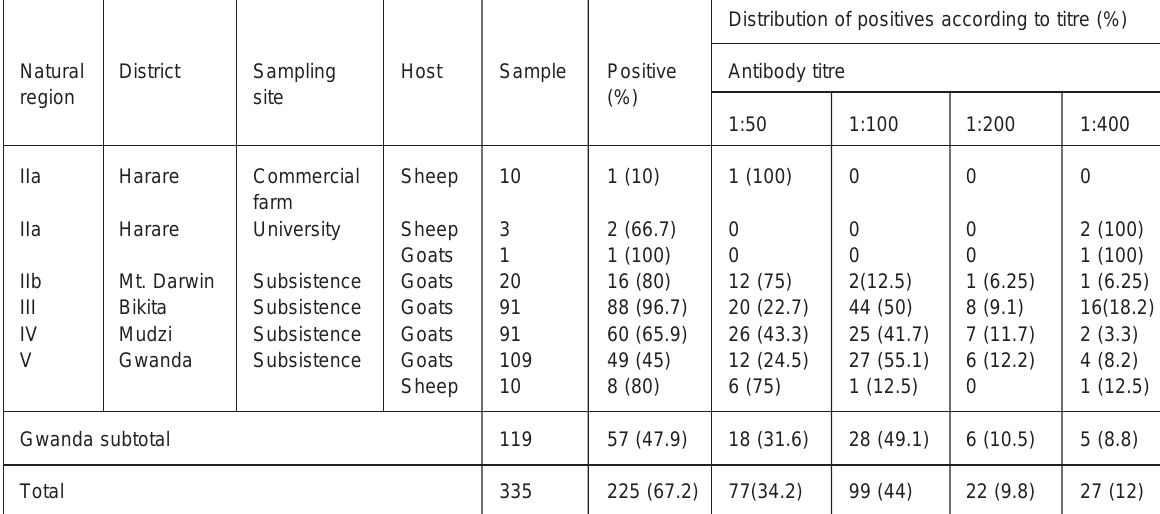
Distribution of positives according to titre (%)